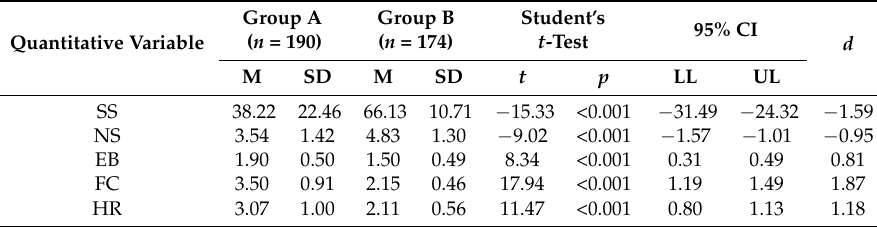
Table 2. Comparison of the results of structural support.